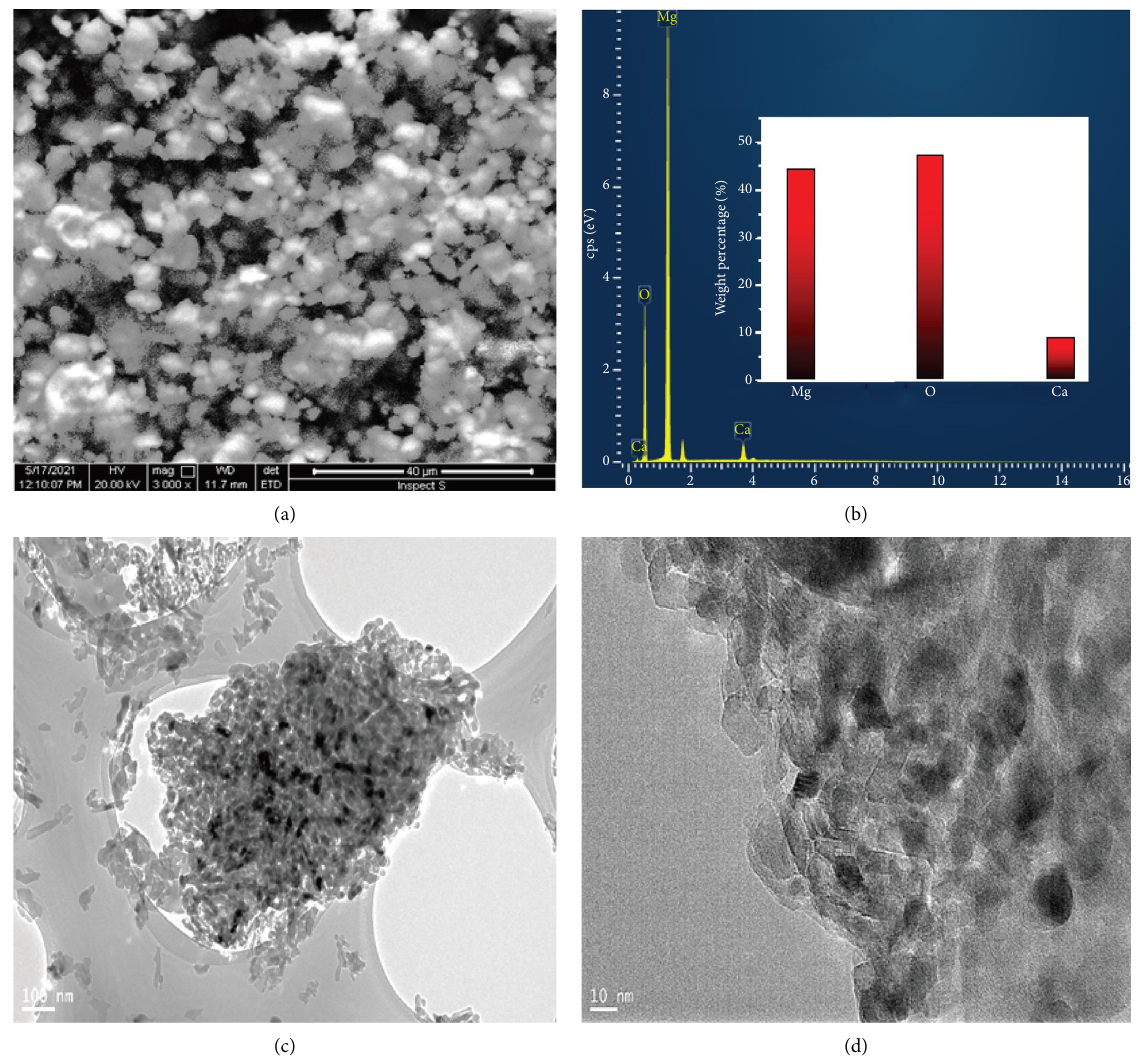
Figure 2: SEM image (a), EDX (b), and TEM images (c) and (d) of the prepared CaO.MgO